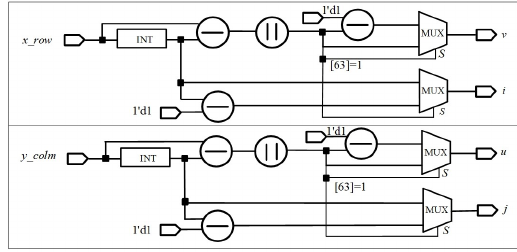
Figure 6. The flowchart of decomposition of coordinate.